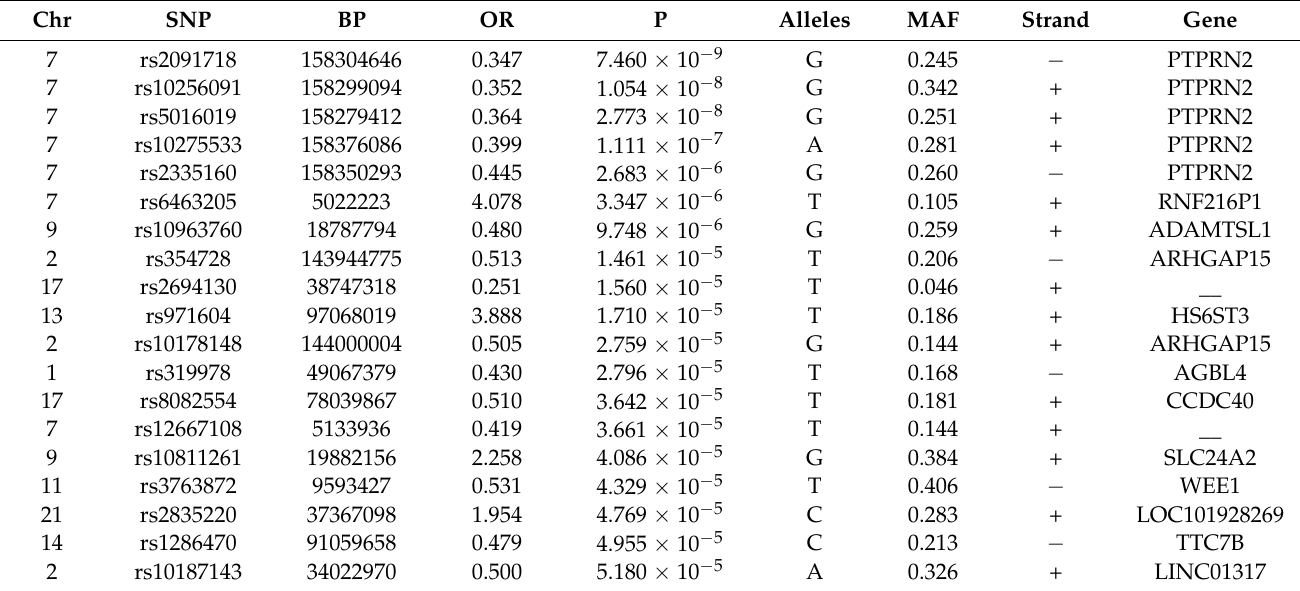
Table 7. Top-ranked SNPs in the GWAS for sweet taste preference (categorical variable) in the whole population. Model adjusted for sex and